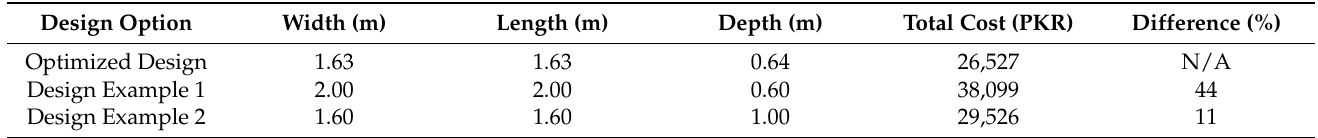
Table 3. Comparison of different conventional and optimized design